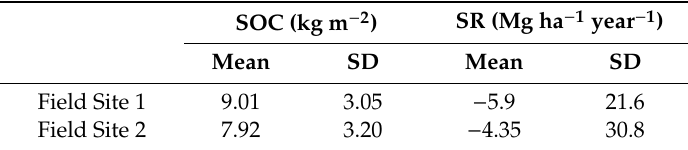
Table 2. Mean and standard deviation (SD) of soil organic carbon (SOC) density and soil redistribution rate (SR) at two field